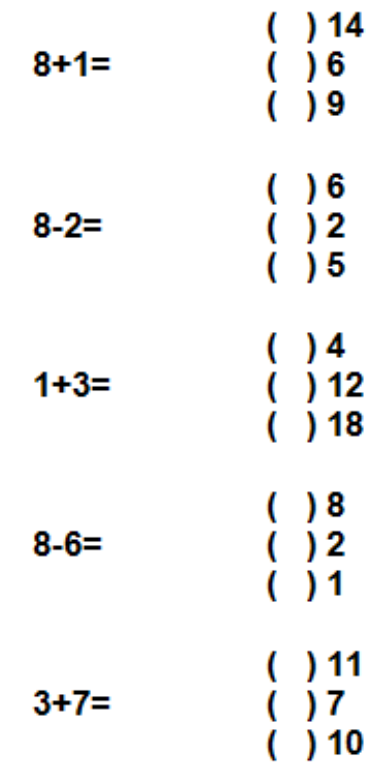
Figura 1 . Exemplo dos itens de velocidade de processamento na modalidade numérica da